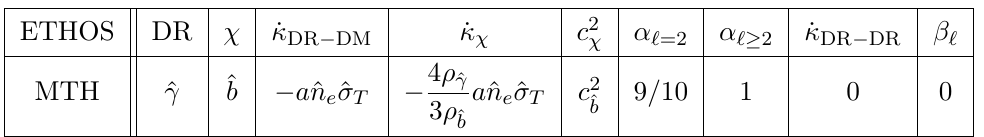
Table 1. The mapping used between the ETHOS framework [87] and the MTH model to utilize the interacting dark matter-dark radiation (IDM-DR) Boltzmann equations for the twin sector. χ is the IDM in the ETHOS